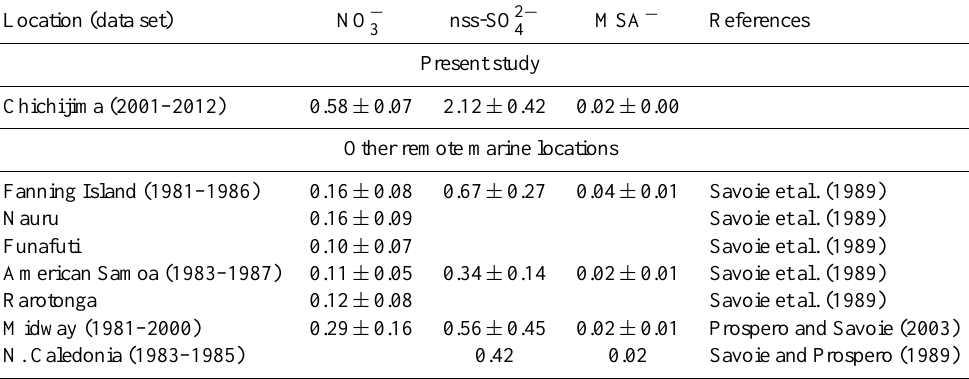
Table 4. Mean concentrations of major water-soluble species at Chichijima Island from 2001 to 2012 and those at several other remote marine locations in the